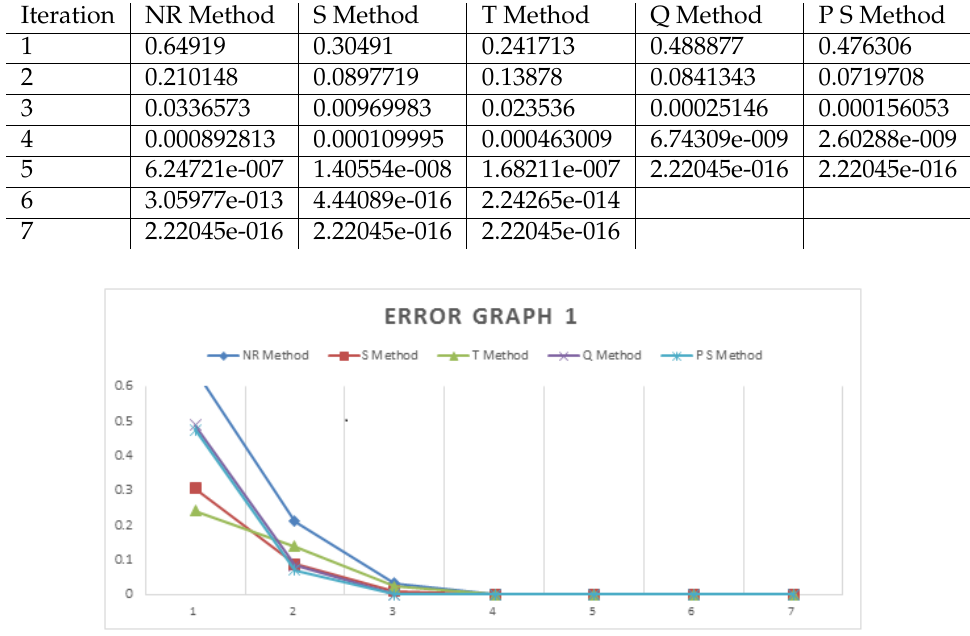
Figure 1. Graphical comparison of error analysis for the Equation (18)